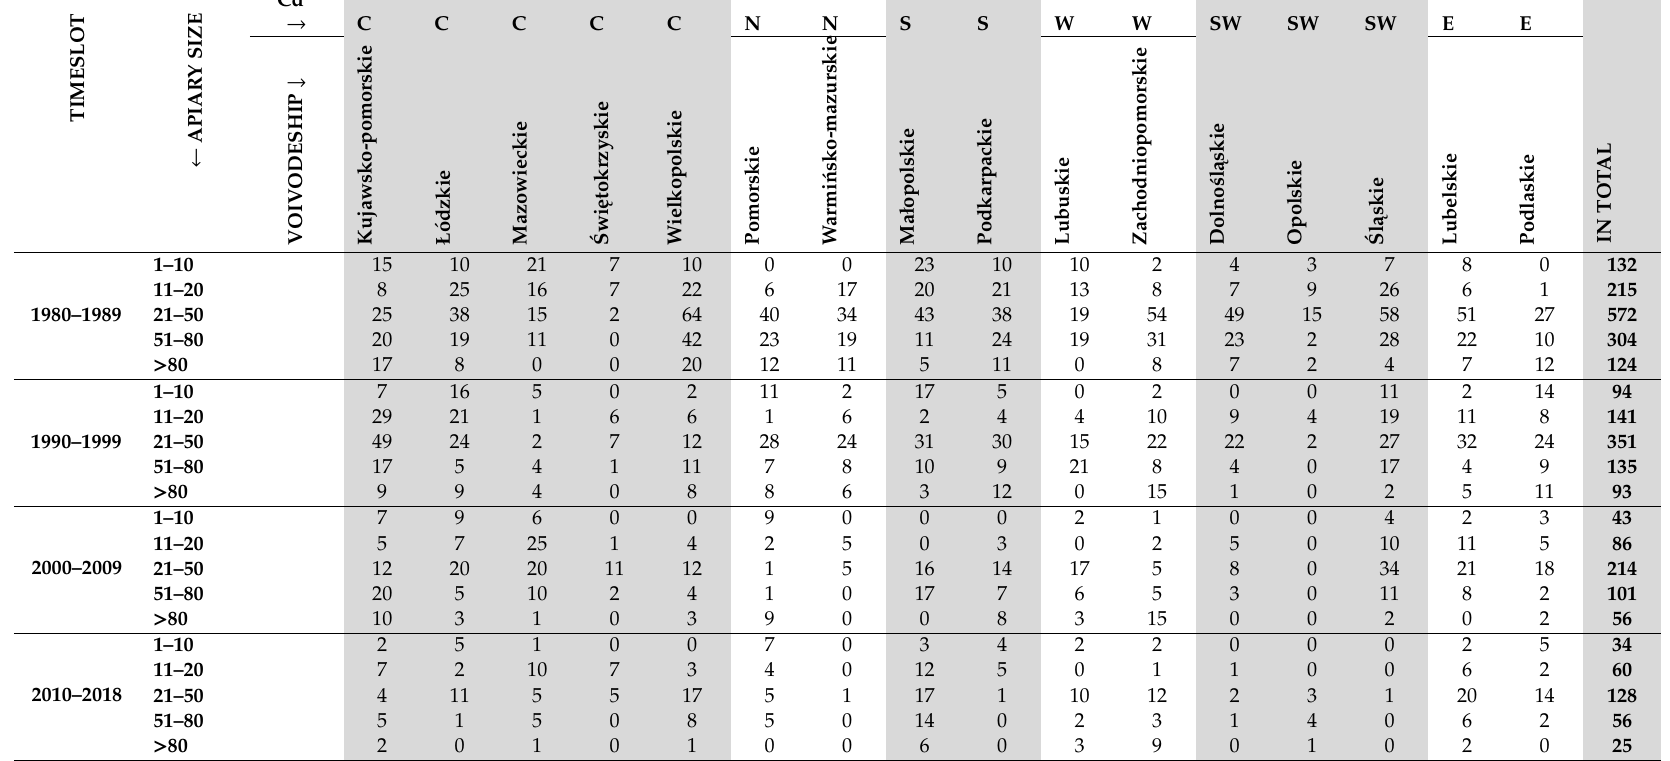
Table 1. Number of questionnaires by decade timeslot and by apiary size and geographical